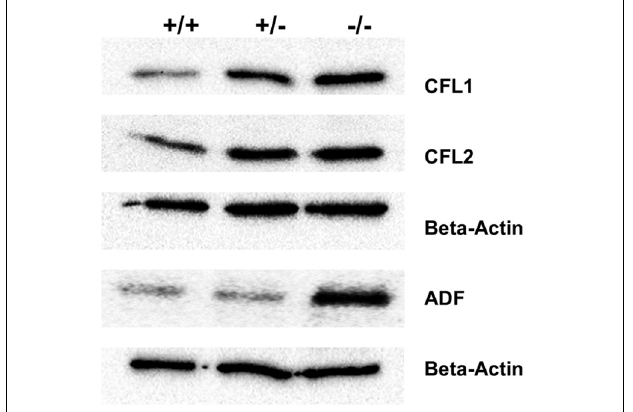
FIGURE 10 | Immunoblotting against ADF, CFL1, and CFL2 on protein lysates from Pfn3 + / + , Pfn3 + / − , and Pfn3 − / − testes.